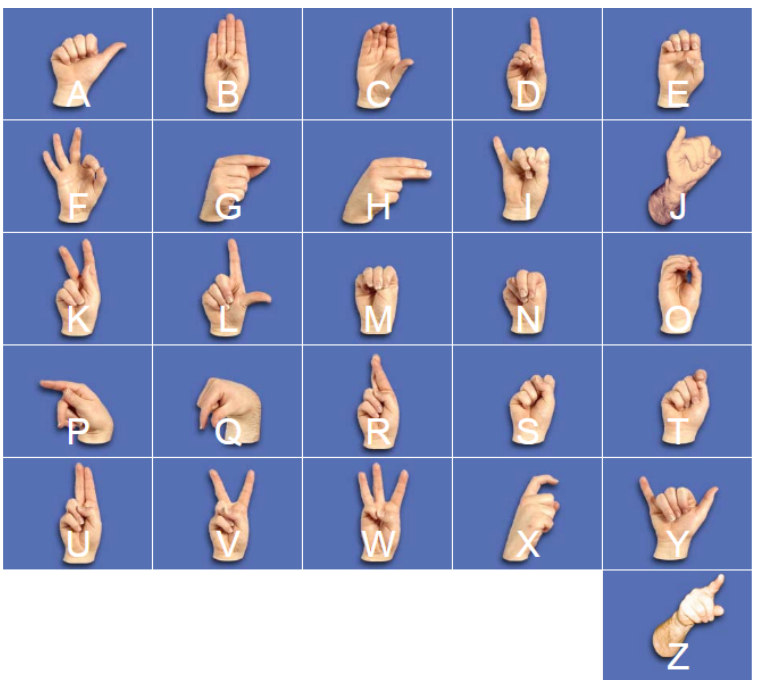
Figure 2: ASL fingerspelling system (from BSL SignBank; http://bslsignbank.ucl.ac.uk/spell/onehanded.html; Fenlon et